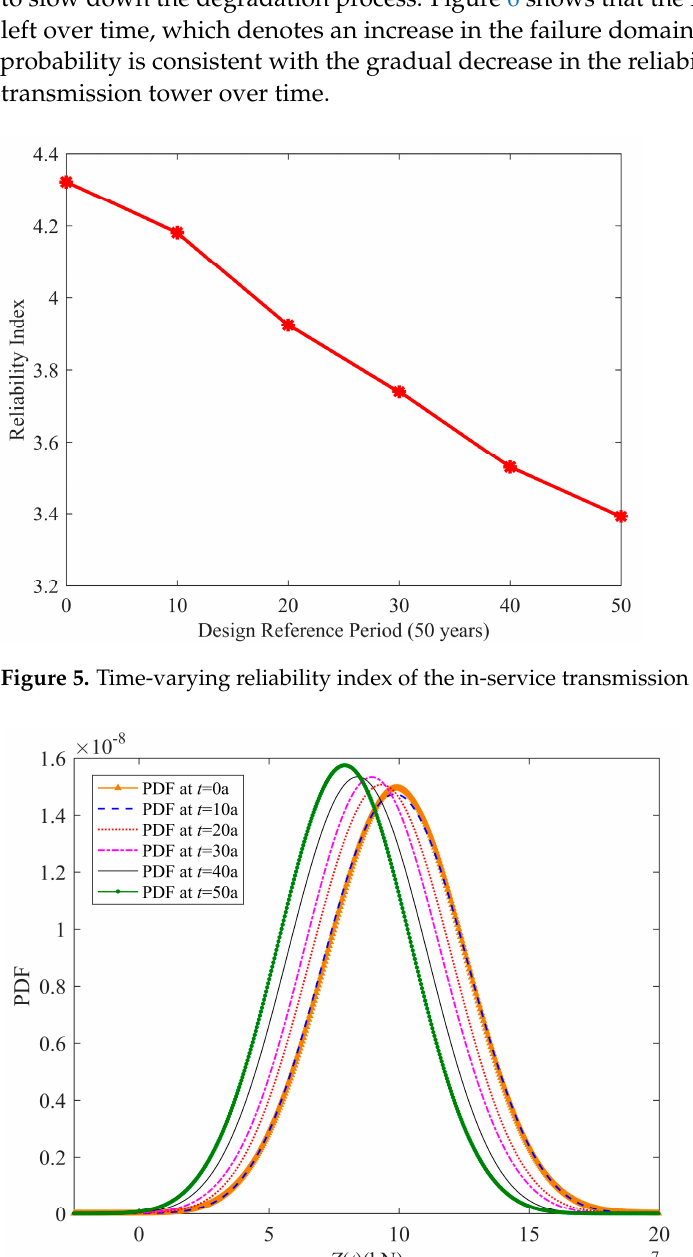
Figure 6. PDF for di ff erent tr.